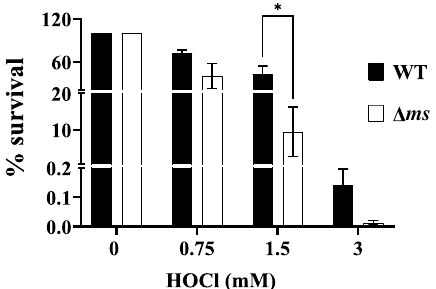
Figure 2. Δ ms strain of S . Typhimurium is hypersensitive to HOCl: WT and Δ ms strains of S . Typhimurium were grown in LB broth up to late stationary phase. The cultures were then exposed to indicated concentrations of NaOCl for 2 h. Following exposure, the cultures were serially diluted and plated on HEA plates. Colonies were enumerated following incubation of the plates, expressed in percentage of recovered viable cells. Results are shown as mean ± SE (n = 3) and is representative of two experiments. * p < 0.05.